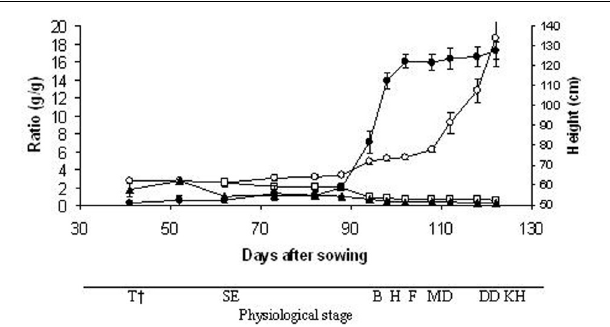
FIGURE 4 | Time-courses of concentrations of phenolic compounds (— (cid:2) , 4-hydroxybenzoic acid; — (cid:2) , vanillic acid; — • , syringic acid; — (cid:4) , vanillin; —*, p -cumaric acid; — (cid:3) , syringaldehyde; — ♦ , ferulic acid). † T, tillering; SE, stem elongation; B, booting; H, heading; F, flowering; MD, milk development; DD, dough development; KH, kernel hard.